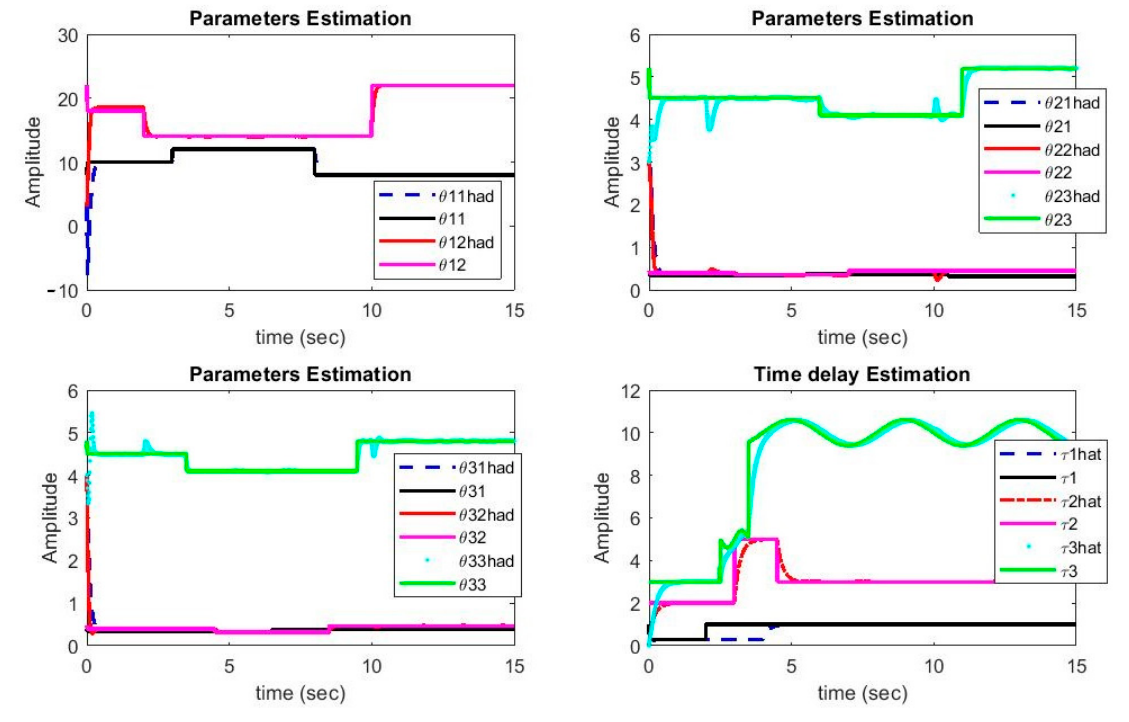
Figure 4. Plots of parameters and delays estimations versus time.